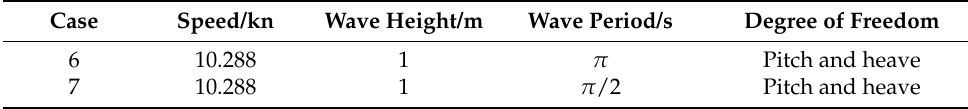
Table 5. Simulation conditions in calm